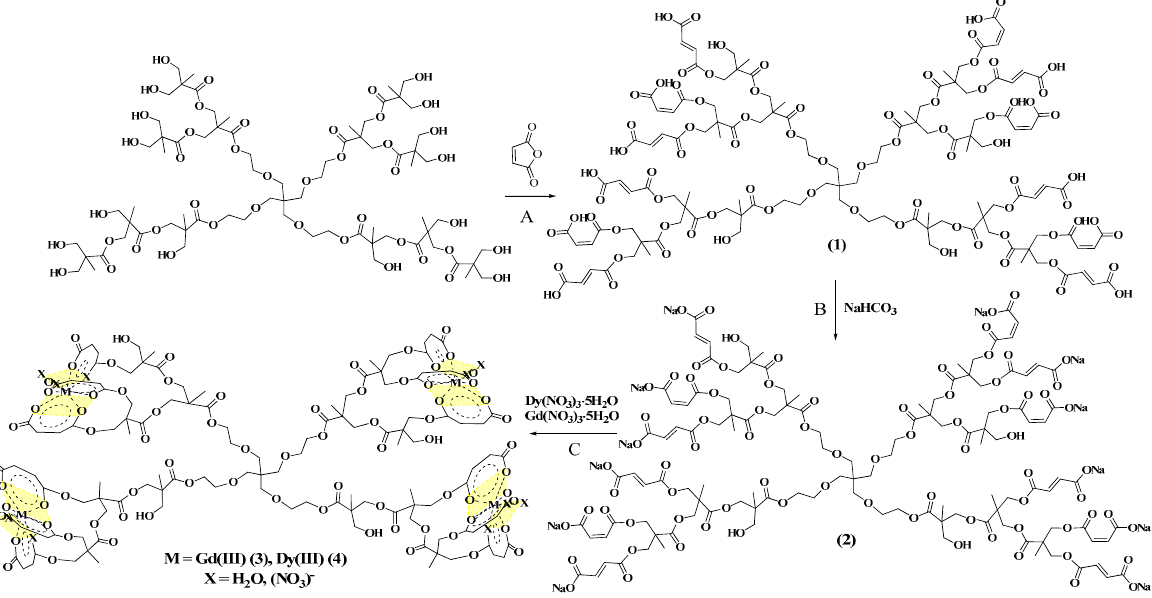
Figure 1. Synthesis of hyperbranched polyester polyfumaratomaleate 1 , salt 2 and complexes with